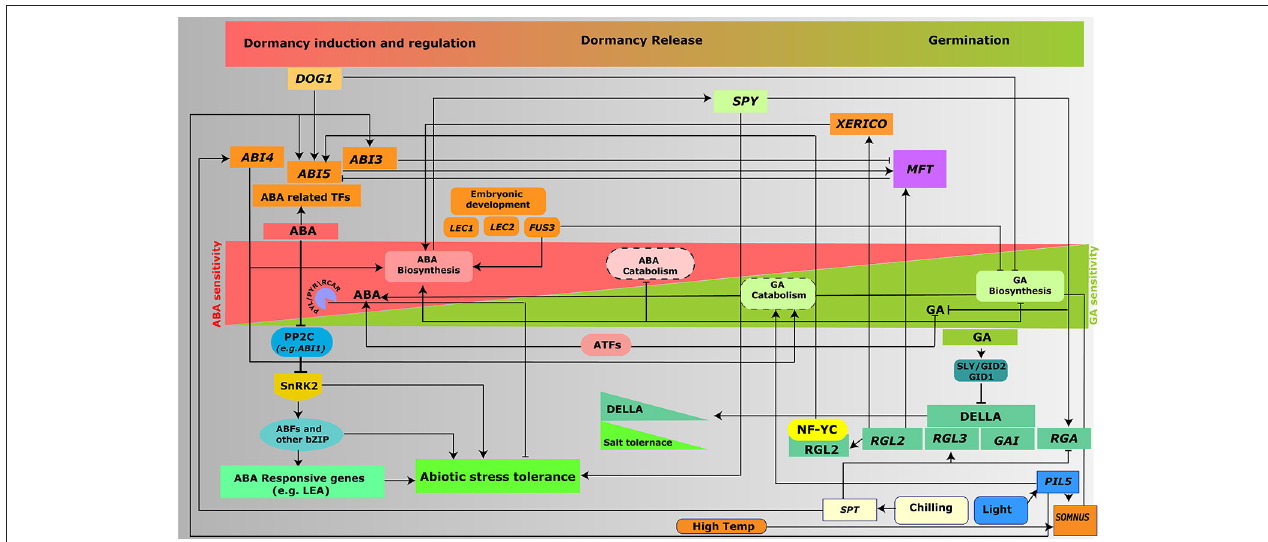
FIGURE 2 | Interplay of ABA and GA signaling in the regulation of seed germination and abiotic stresses. Switch from seed dormancy to germination is controlled by the intricate balance between ABA and GA levels. ABA- and GA-signaling and metabolism genes regulate the expression of various genes (as mentioned in the text) and hence control two of the major aspects of plant development, germination and response to abiotic